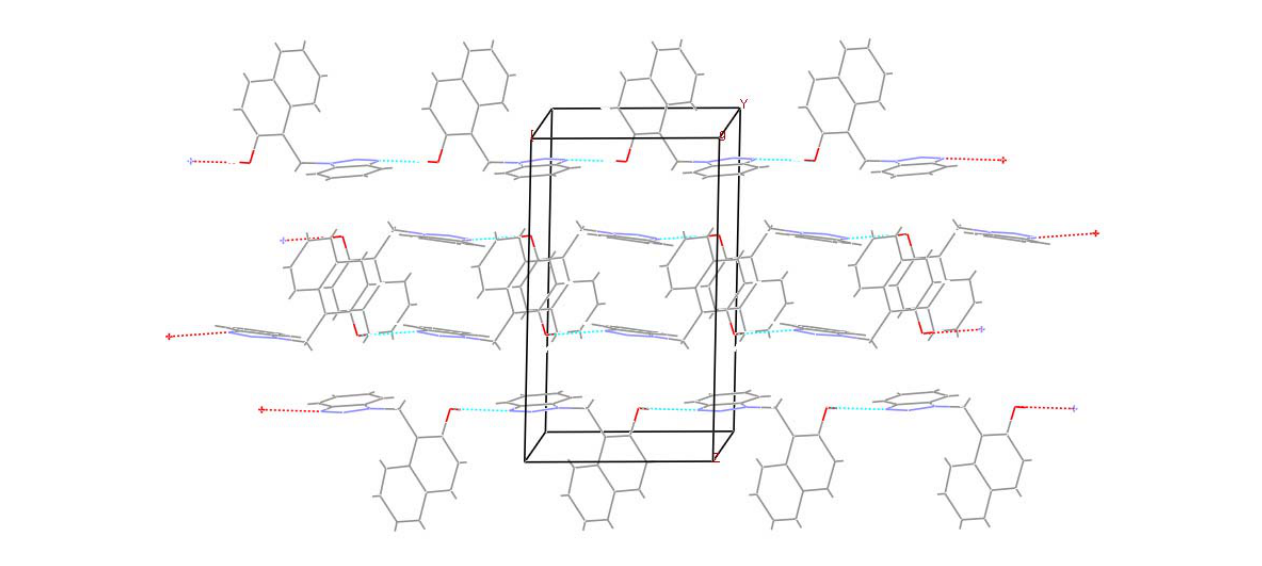
Figure 2. Crystal packing diagram of 6 , showing an extended hydrogen-bonded